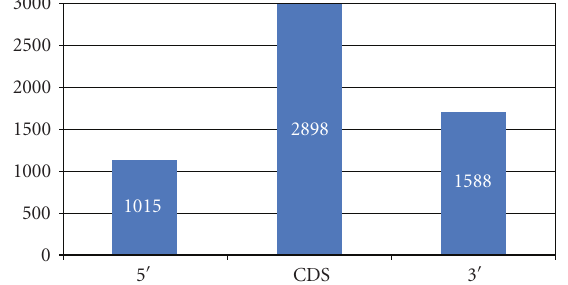
Figure 3: Distribution of predicted target sites in 5 (cid:2) UTR, CDS and 3 (cid:2) UTR as predicted using